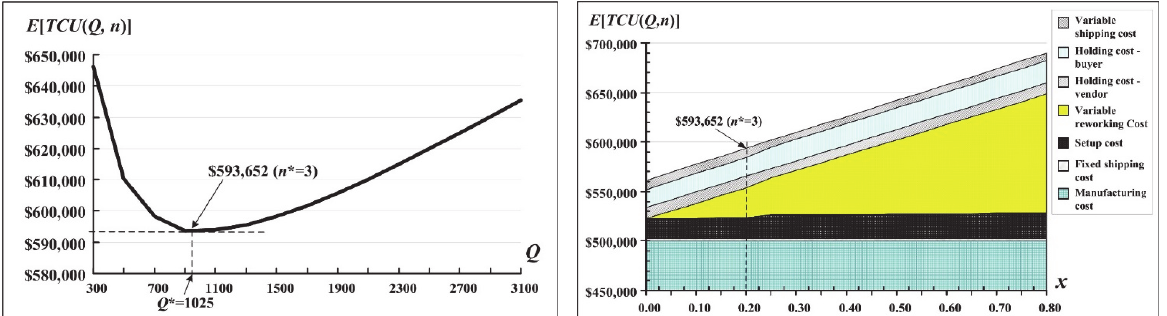
Fig. 6. Effect of nonconforming rate on different system cost components of E [ TCU ( Q , n